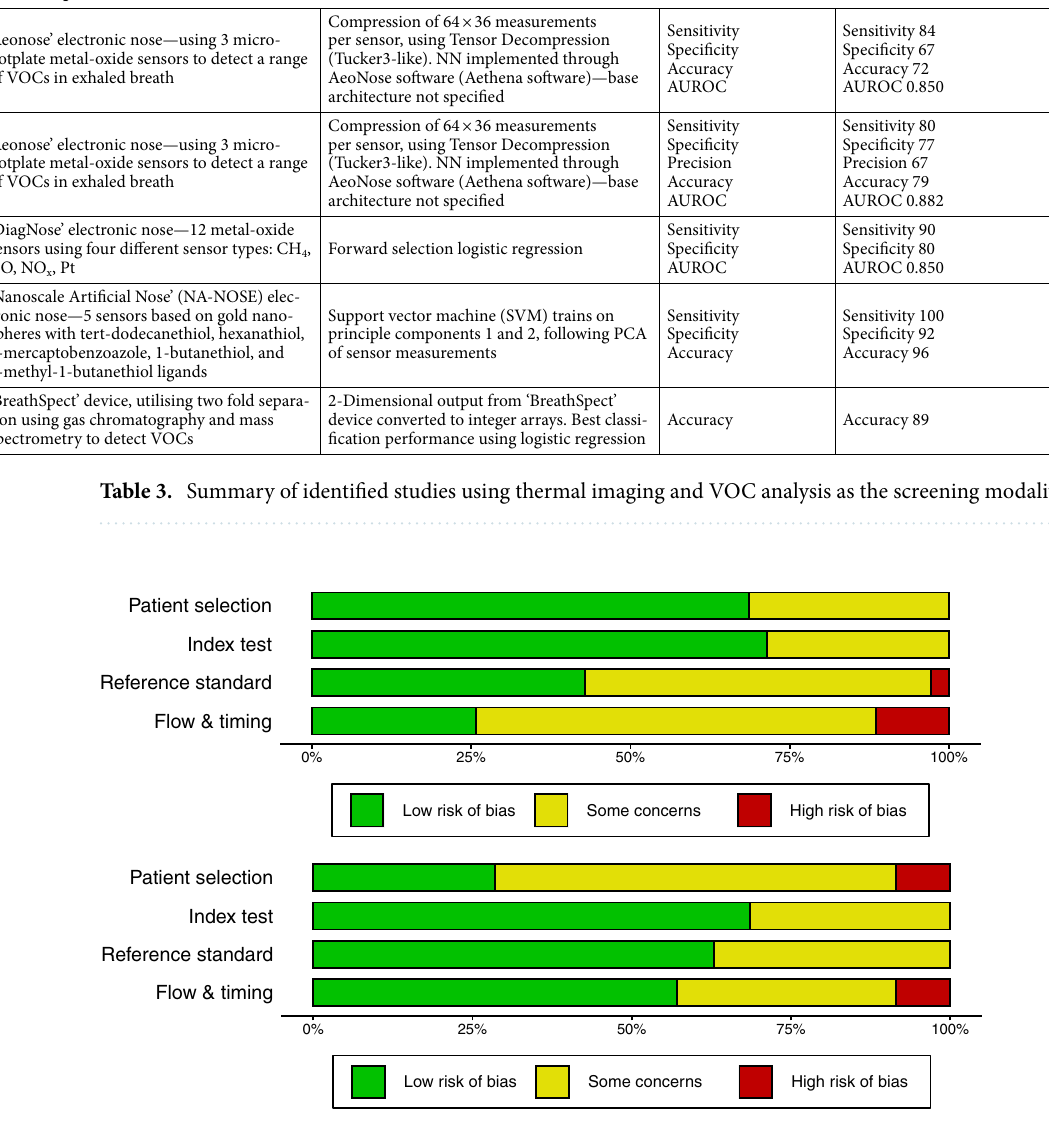
Figure 2. Summary plots of ‘Risk of bias’ (top panel) and ‘Applicability’ (bottom panel) using the QUADAS-2